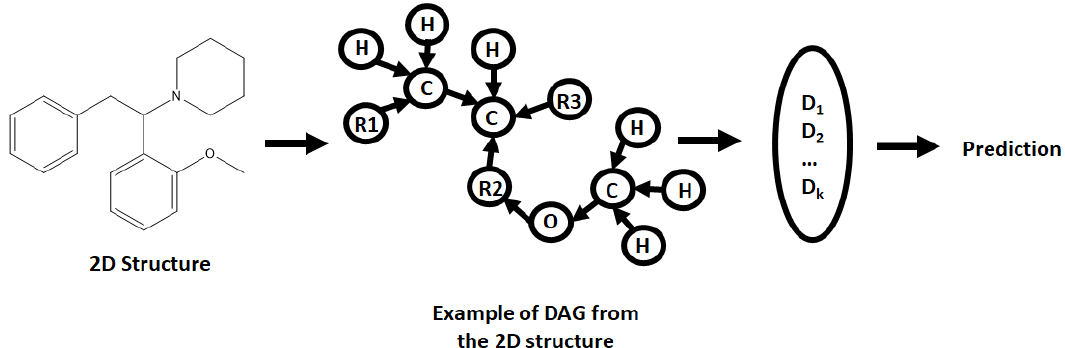
Figure 1. Examples of how a molecule (2-methoxphenidine) can be converted into a directed acyclic graph (DAG), and then how the sum of different root versions of the DAG are used for a prediction.